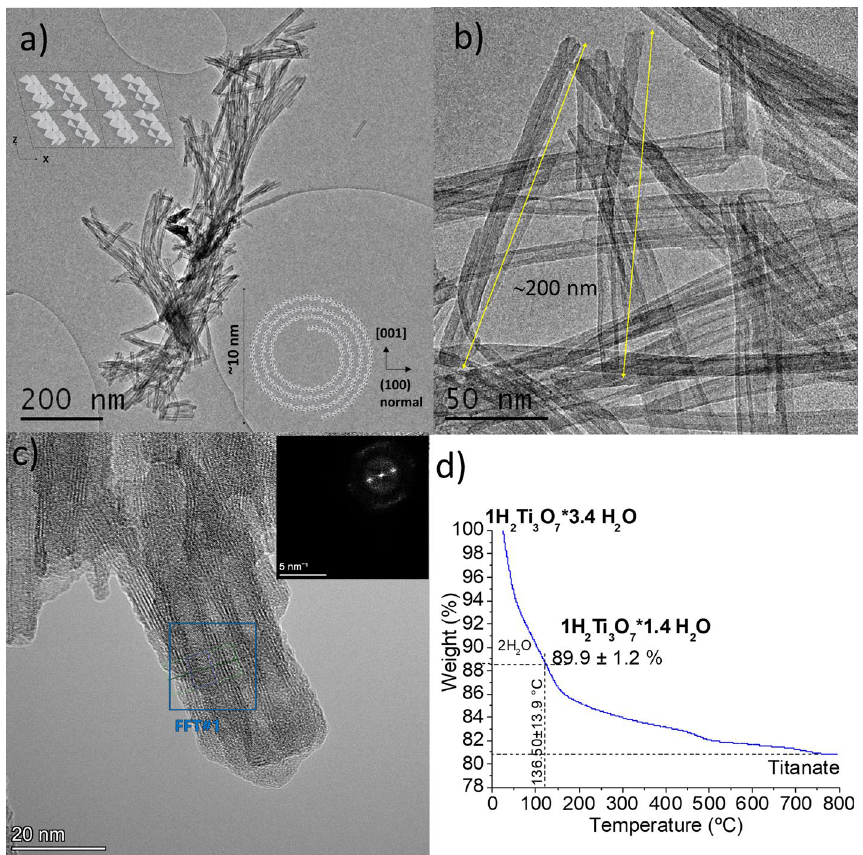
Figure 2. T1 TEM micrographs of sample T1 at different magnifications ( a , b ) in a JEOL JEM-2011 operated at 200 kV, schematic drawing of the structure of H 2 Ti 3 O 7 NTs (inset in a ), and ( c ) in a TALOS G-2 TEM at 200 kV. The inset is a Fourier transform taken from the area of the tube only marked by the blue box. A more detailed analysis of the TEM micrographs (Figure S2 in ESI) showed tubular cavities with diameters in the range of 9–11 nm as well as difference in thicknesses of opposite walls of the tubes). ( d ) Thermogravimetric analysis of T1.